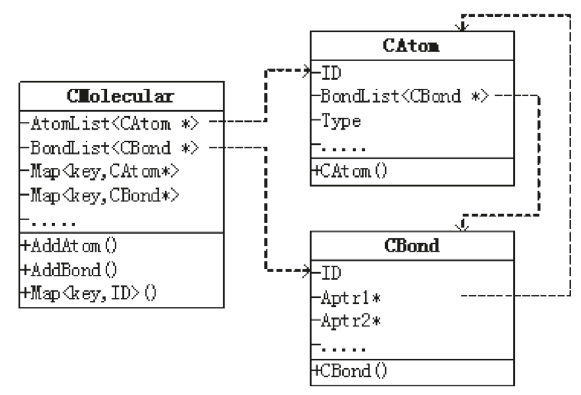
Figure 1: Data structure of